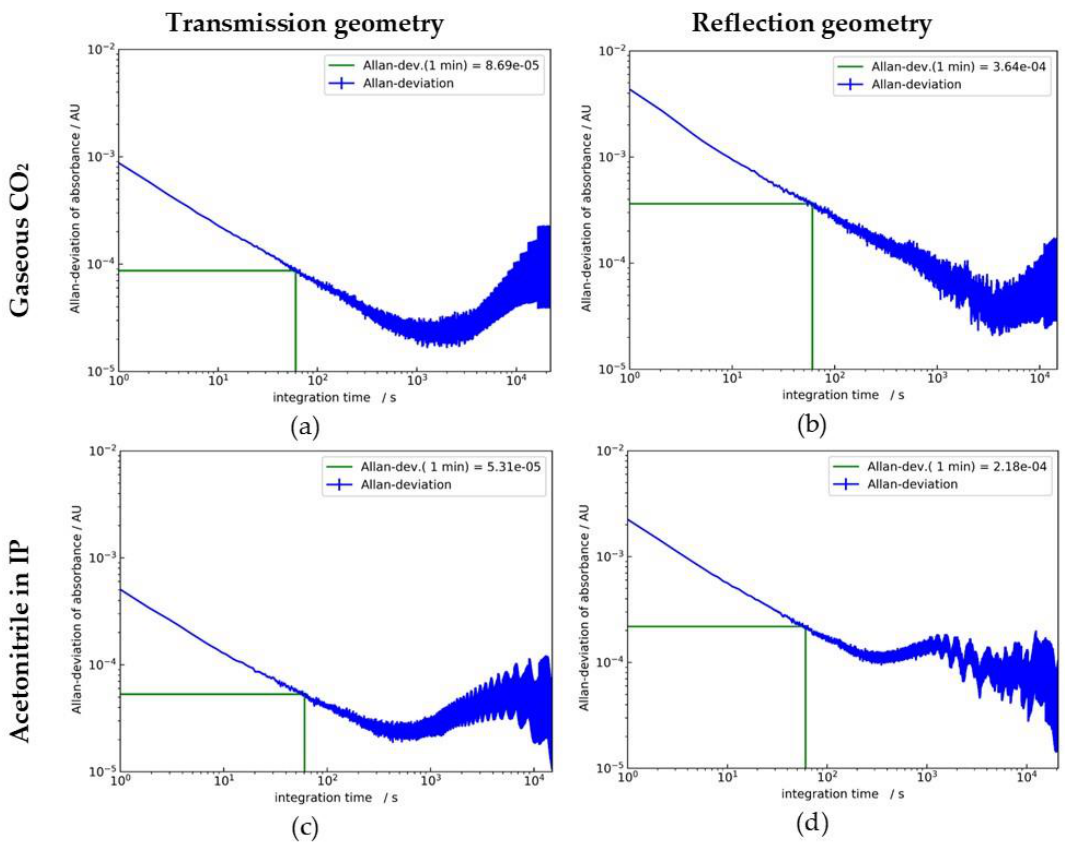
Figure 11. Allan deviation plots for ATR measurements with sapphire tubes. ( a ): CO 2 pressure steps transmission setup; ( b ): CO 2 pressure steps reflection setup; ( c ): acetonitrile in the isopropanol transmission setup; ( d ): acetonitrile in the isopropanol reflection setup. Allan deviations for an averaging time of 1 min were determined from the plots as indicated. Table 3. Analysis of the ATR experiments with sapphire tubes. NEC (1 σ )-values for Basonat respectively TDI are estimated using the conversion factors from Table